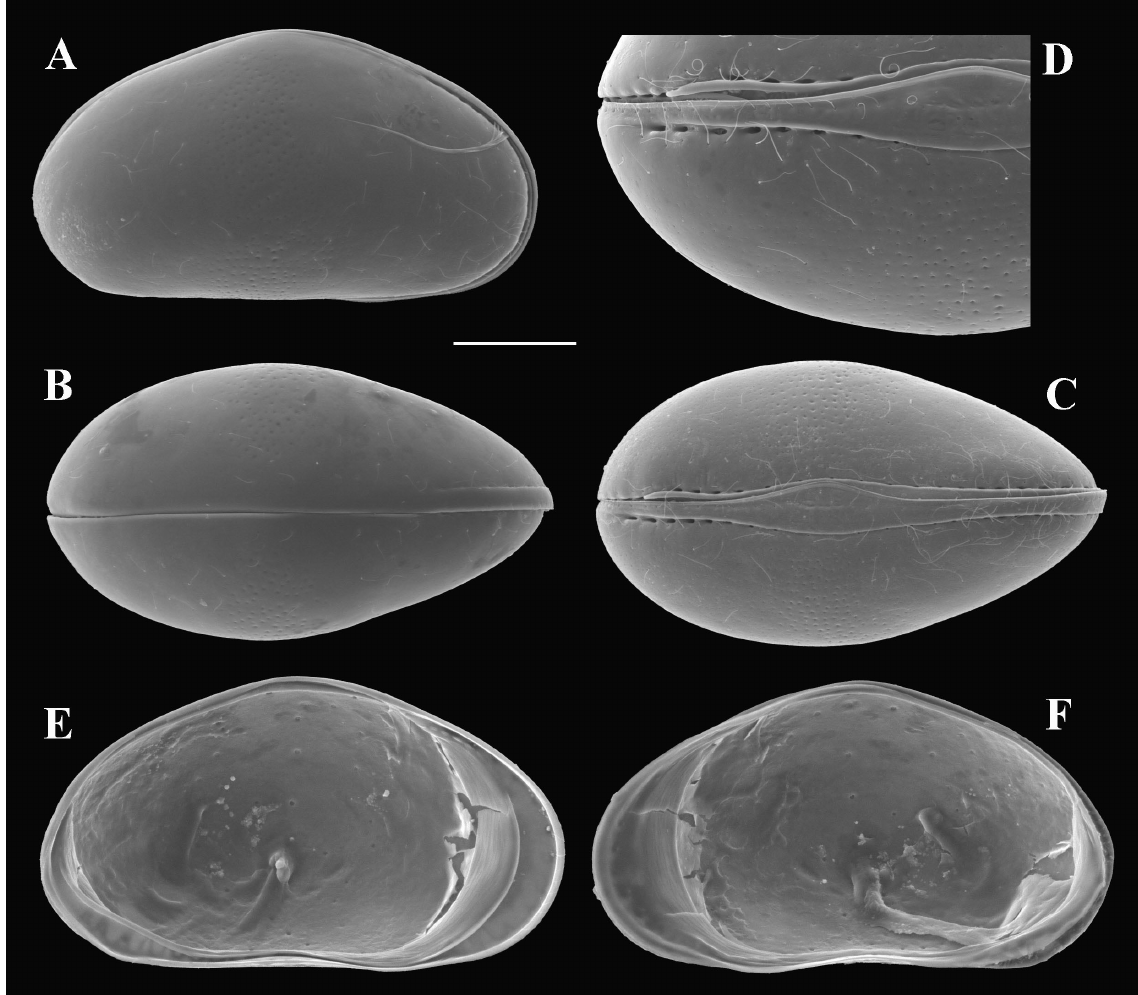
Fig. 1. Cyprettadopsis sutura gen. et sp. nov., ♀. A . Cp, right lateral view (MSU-ZOC.269). B . Cp, dorsal view (MSU-ZOC.270). C . Cp, ventral view (MSU-ZOC.269). D . Posterior part of Cp in ventral view (MSU-ZOC.272). E . LV, internal view (MSU-ZOC.268). F . RV, internal view (MSU-ZOC.268). Scale bar: A–C, E–F = 100 μm; D = 63